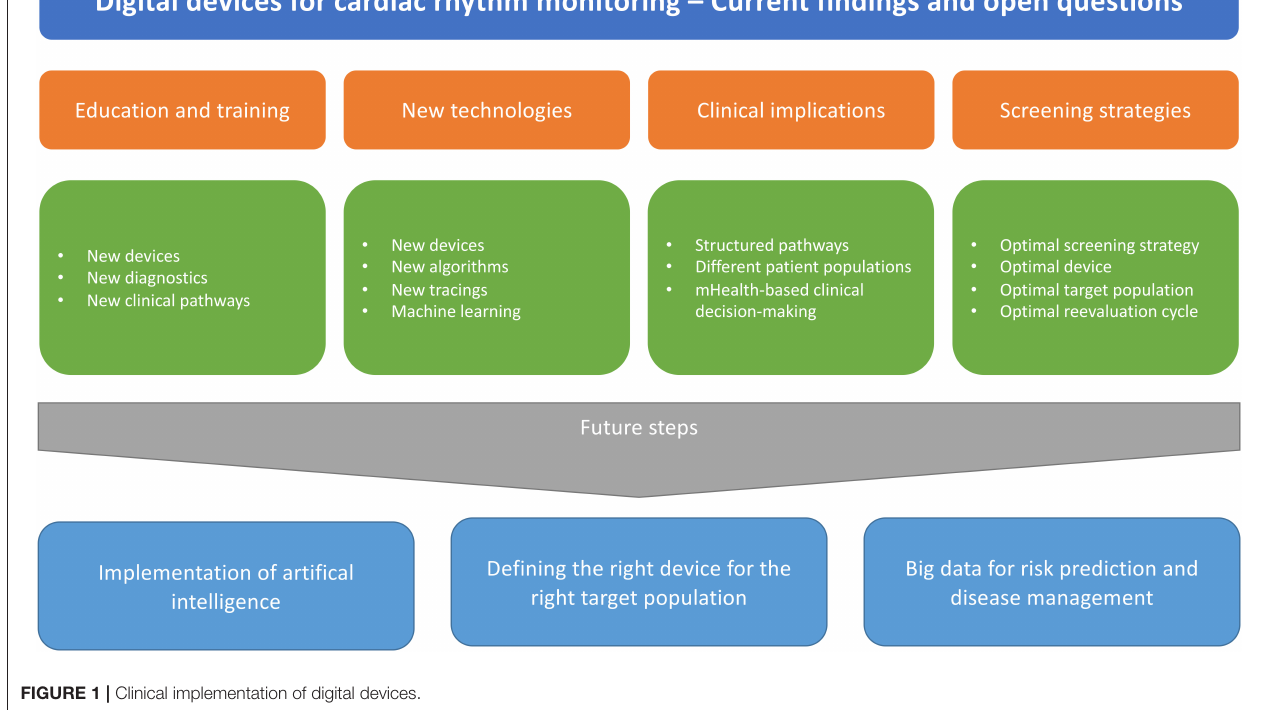
FIGURE 1 | Clinical implementation of digital